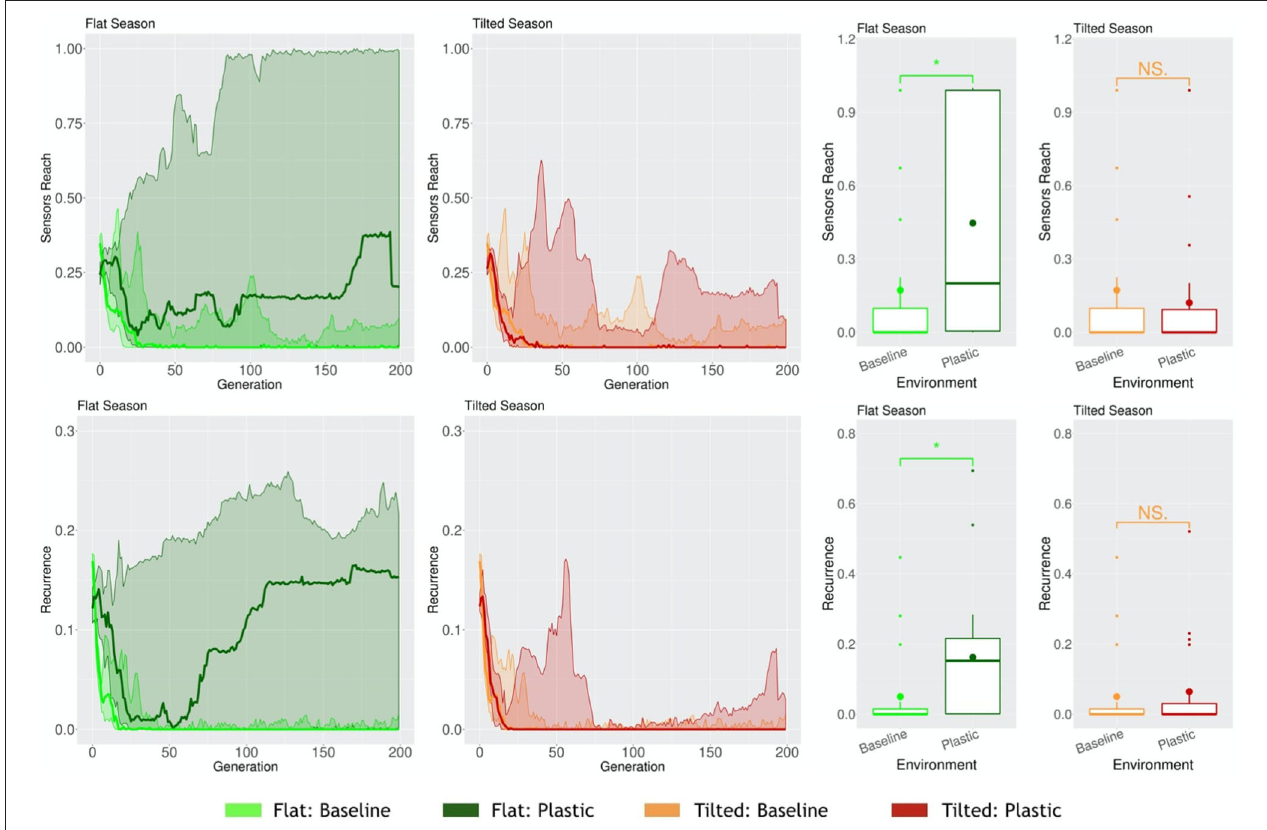
FIGURE 12 | Comparison of controller properties in different environmental conditions. Line plots show the progression of the means of the population (quartiles over all runs), while boxplots show the distribution of the means in the final generation. Significance levels for the Wilcoxon tests in the boxplots are ∗ < 0.05, NS not significant. Note that, naturally, the values of Baseline are the same in Flat or